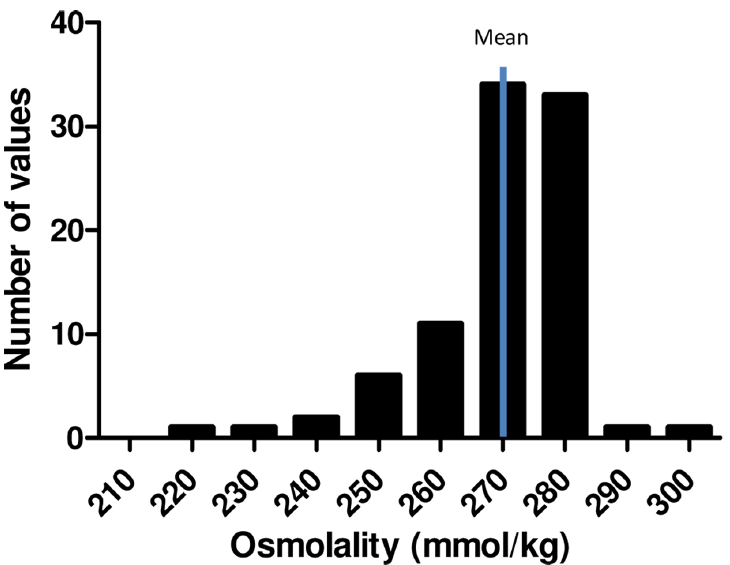
Fig 2. CSF Osmolality Histogram representing Patients and Controls. All 66 participants, 90